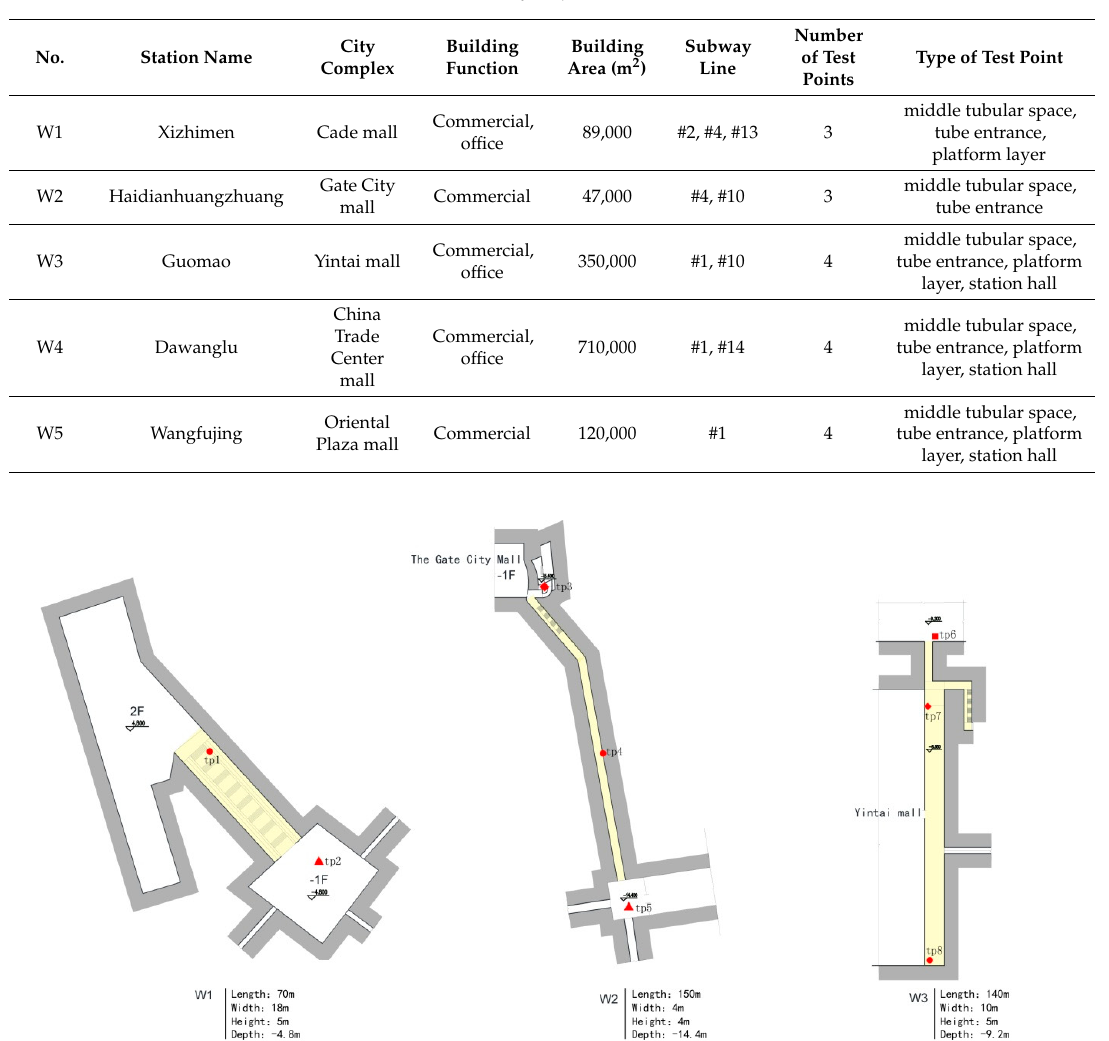
Table 4. Survey object information.